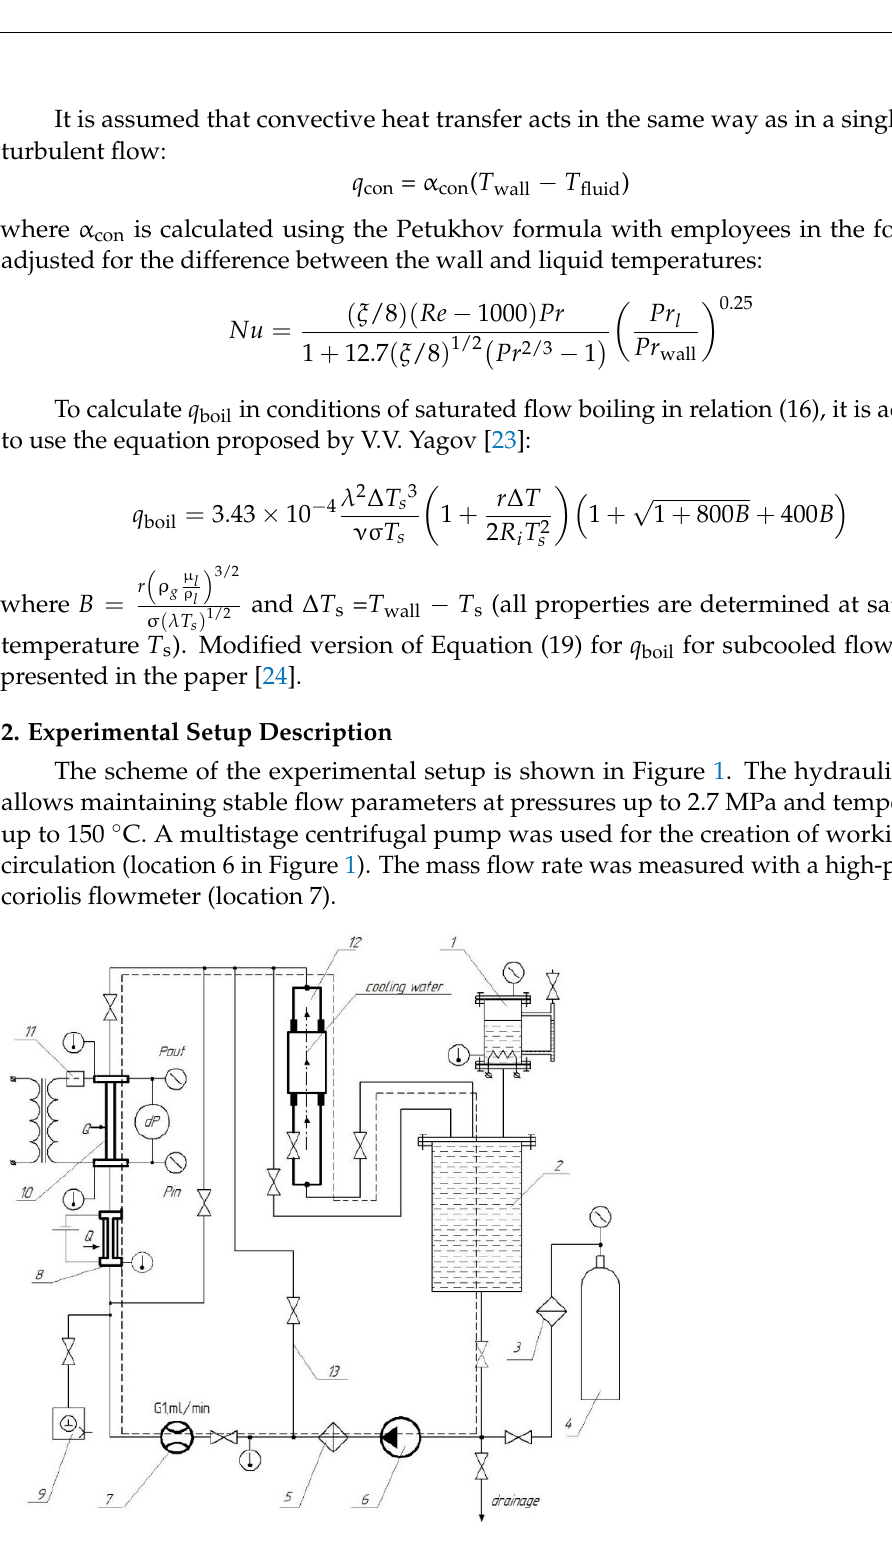
Figure 1. Experimental setup: (1) thermocompressor, (2) tank, (3) and (5) filters, (4) balloon with refrigerant, (6) multistage centrifugal pump, (7) coriolis flowmeter, (8) pre-heater, (9) roughing-down pump, (10) test section, (11) current transducer, (12) recuperative heat exchanger, (13) bypass line.